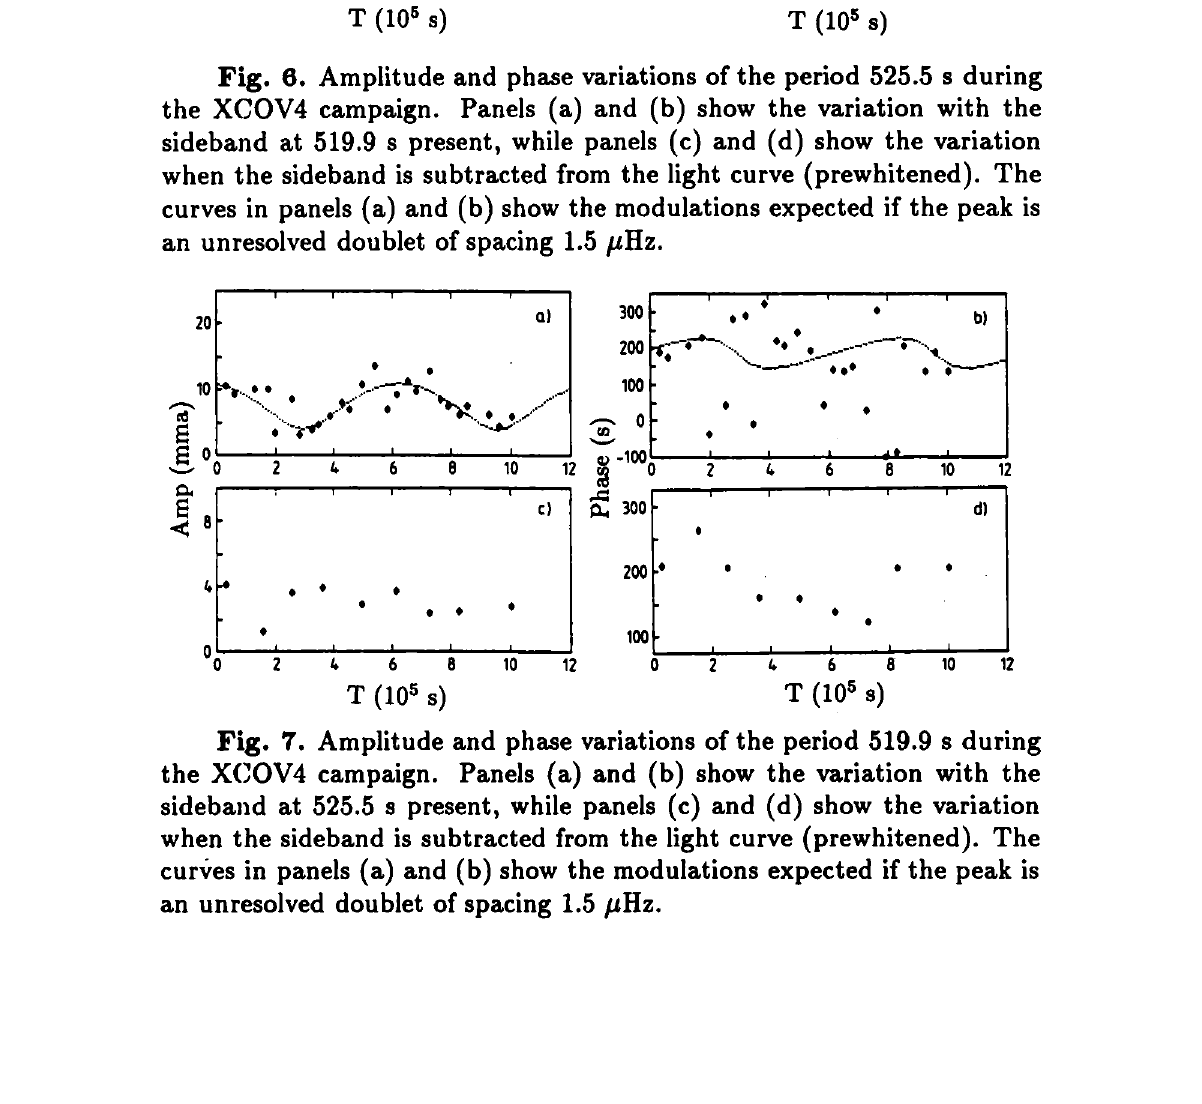
Fig. 7. Amplitude and phase variations of the period 519.9 s during the XCOV4 campaign. Panels (a) and (b) show the variation with the sideband at 525.5 s present, while panels (c) and (d) show the variation when the sideband is subtracted from the light curve (prewhitened). The curves in panels (a) and (b) show the modulations expected if the peak is an unresolved doublet of spacing 1.5